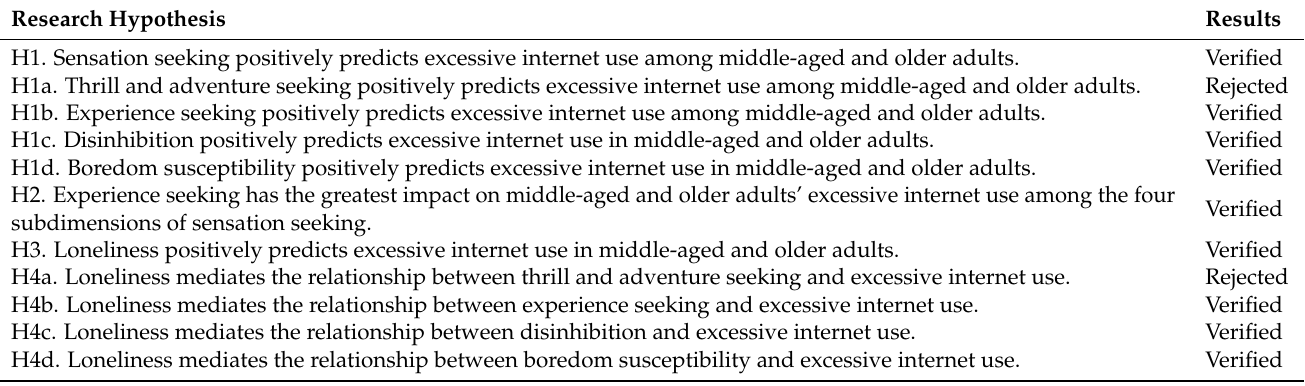
Table 6. Summary of hypothesis testing